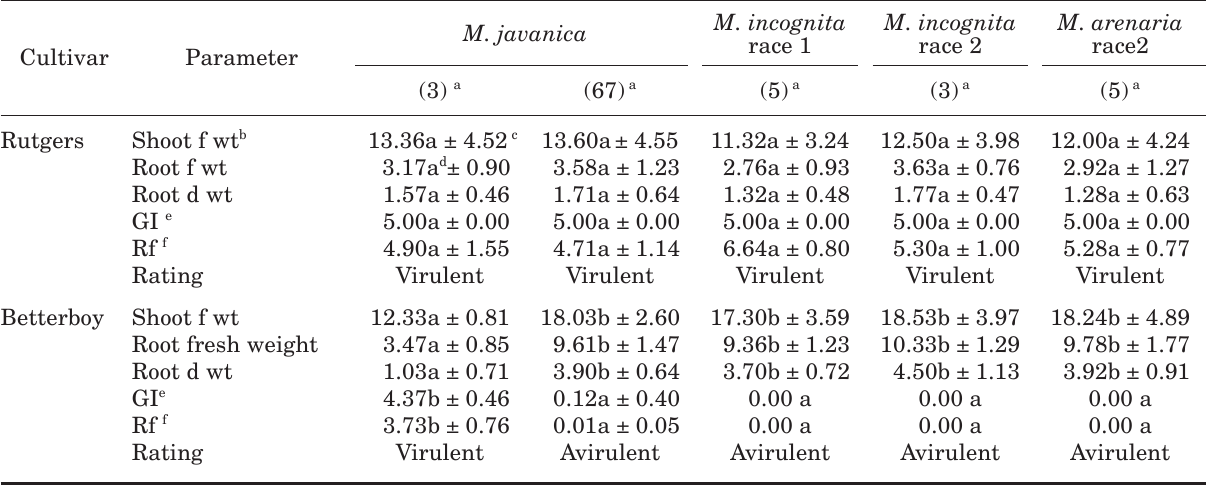
Table 1. Virulence of Meloidogyne isolates against a susceptible (Rutgers) and a resistant (Betterboy) tomato